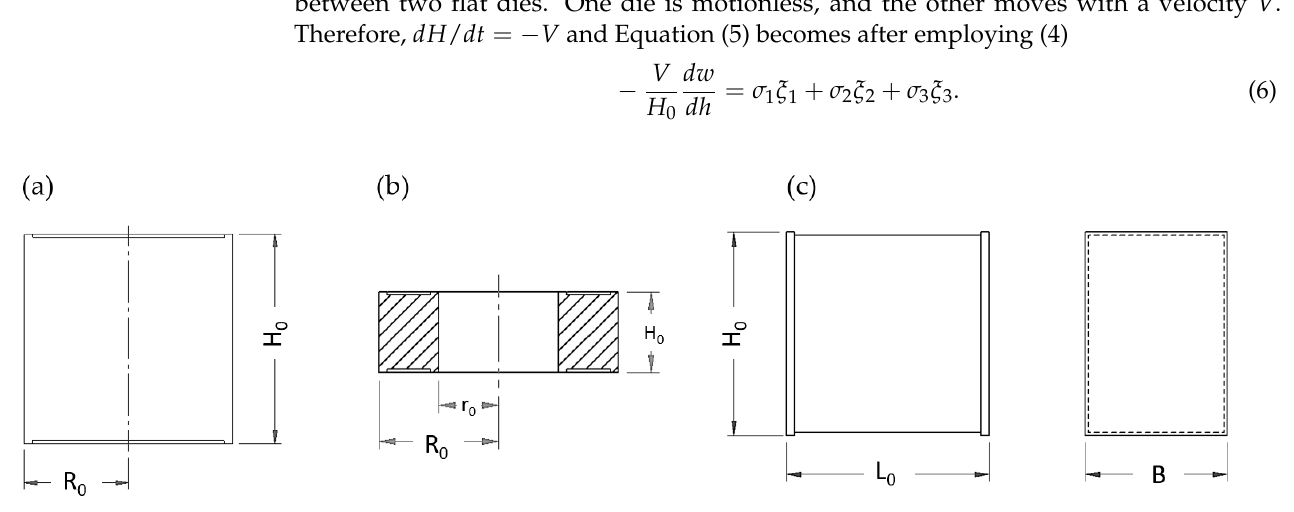
Figure 1. Schematic diagram of specimens: cylinder ( a ), ring ( b ), and prismatic specimens ( c ). The initial condition to this equation is w = 0 (7) for h =